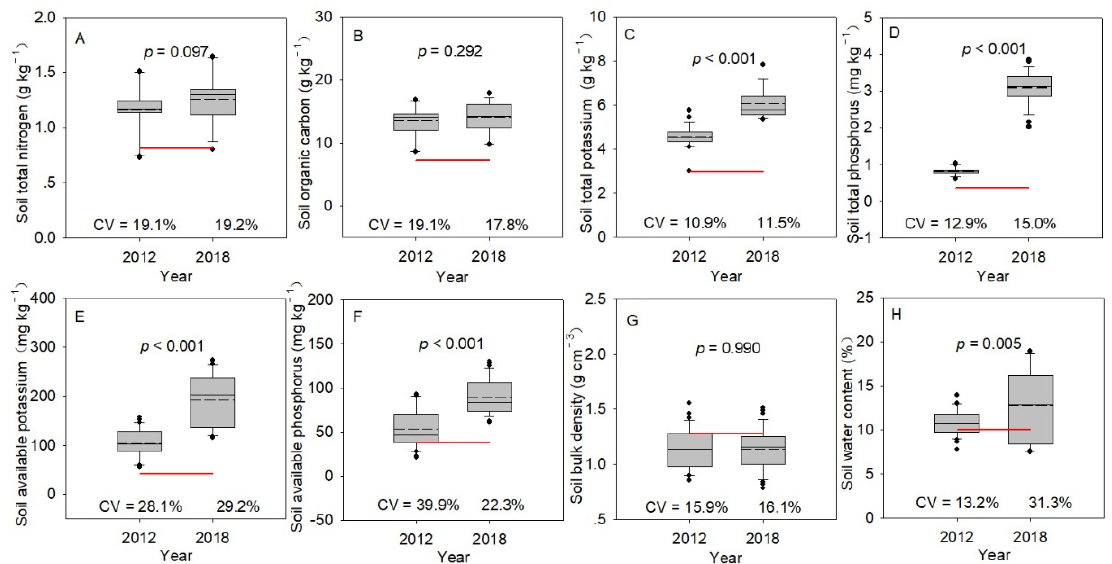
Figure 1. Boxplot and coefficient of variation of eight soil properties of the 0–20 cm layer in 2002, 2012 and 2018. CV is variable coefficient of each soil property in 2012 and 2018. p is significance level of soil properties between 2012 and 2018. The red line represents the basic soil indicators in 2002. ( A ), soil total nitrogen. ( B ), soil organic carbon. ( C ), soil total potassium. ( D ), soil total phosphorus. ( E ), soil available potassium. ( F ), soil available phosphorus. ( G ), soil bulk density. ( H ), soil water